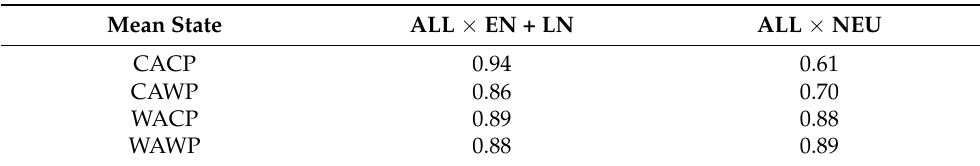
Figure 6. Austral summer SAT anomaly composites of ALL-years during the: ( a ) CACP, ( b ) CAWP, ( c ) WACP, and ( d ) WAWP mean states; of EN + LN-years during the: ( e ) CACP, ( f ) CAWP, ( g ) WACP, and ( h ) WAWP mean states; of NEU-years during the: ( i ) CACP, ( j ) CAWP, ( k ) WACP, and ( l ) WAWP mean states. Continuous contours encompass the significant anomalies at a 90% confidence level using the Student’s t -test. The symbol σ above the colour bar means standard deviation. Table 6. Austral summer pattern correlations for SAT between ALL and EN + LN composites and between ALL and NEU composites in each mean state.